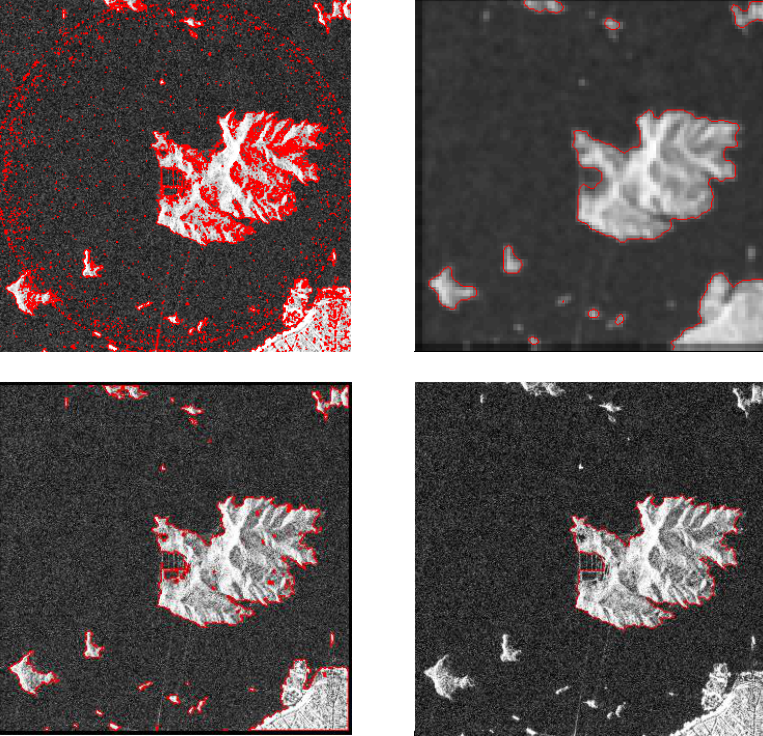
Figure 3. The coastline segmentation results of SAR image: (a) ordinary C-V model result, (b) low scale image sequence result, (c) exponential multi-scale C-V model result, (d) automated coastline segmentation